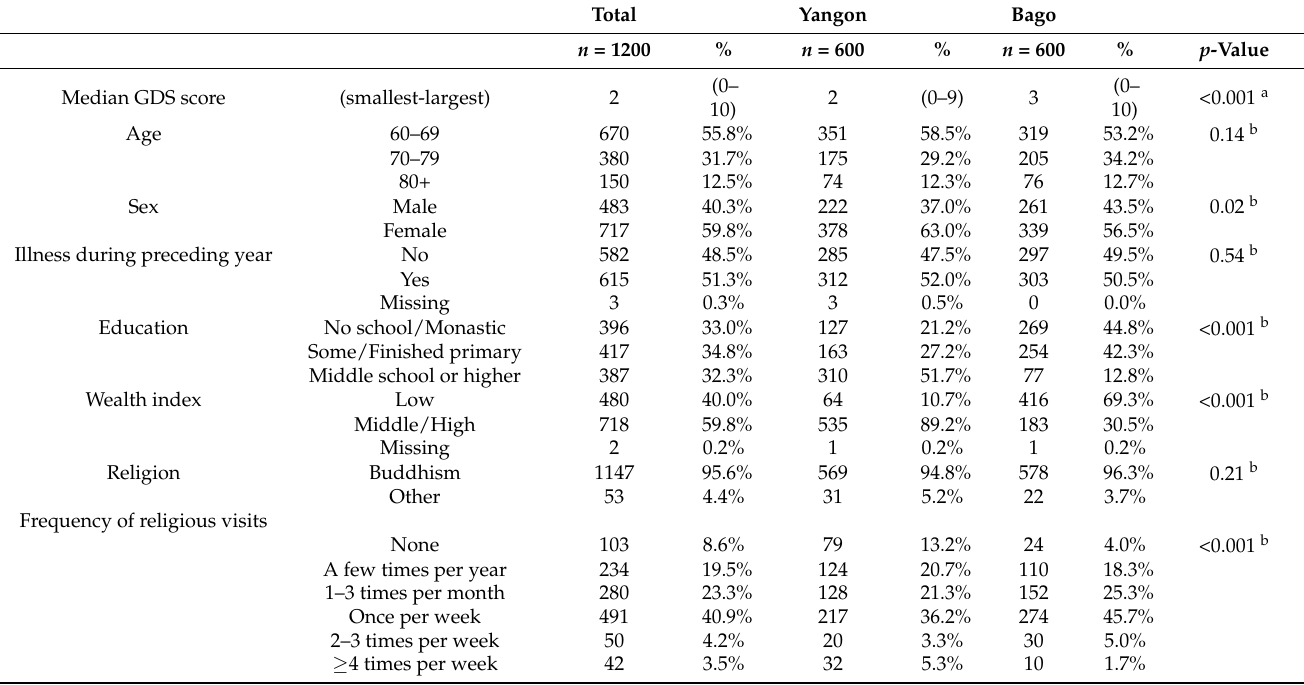
Table 1. Socio-demographic characteristics.